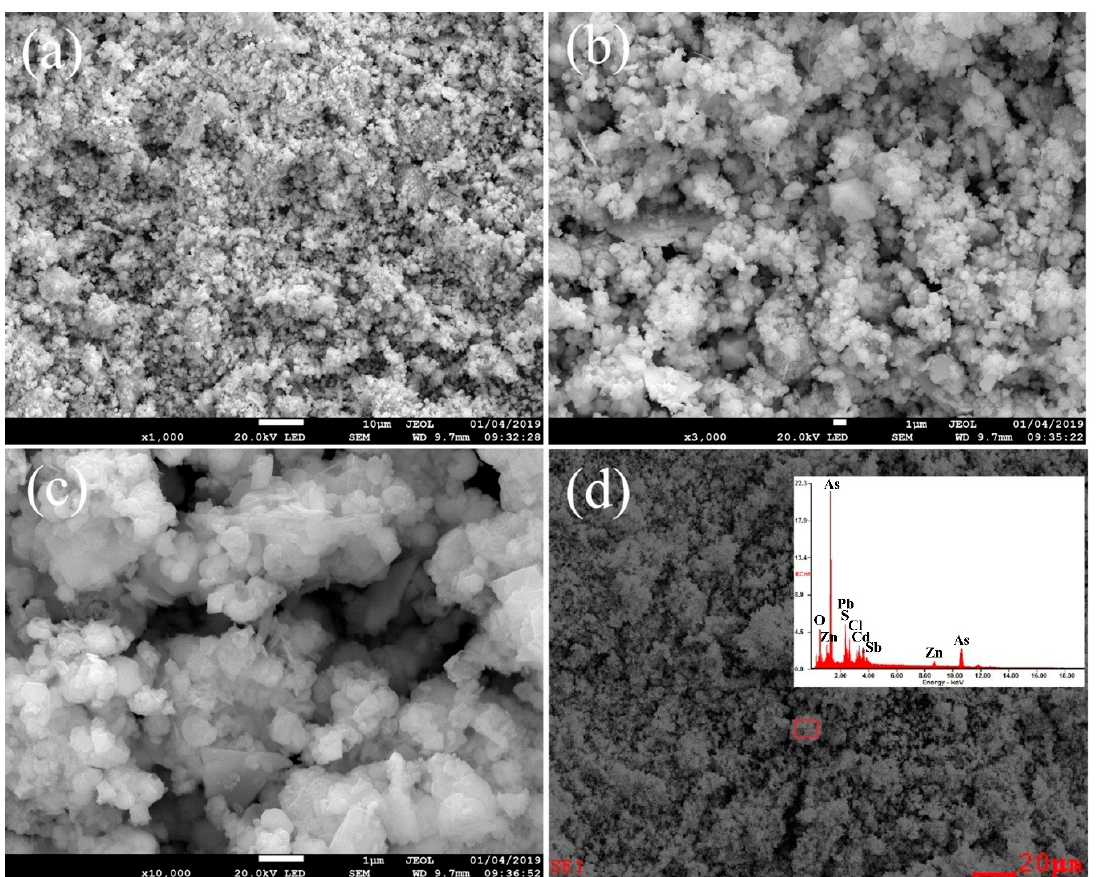
Figure 2. SEM images of the high-arsenic dust at 1000 times magnification ( a ), 3000 times magnification ( b ), and 10,000 times magnification ( c ); and EDS pattern with the corresponding area ( d ).